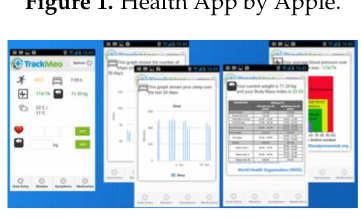
Figure 2. TrackMeo by Google.